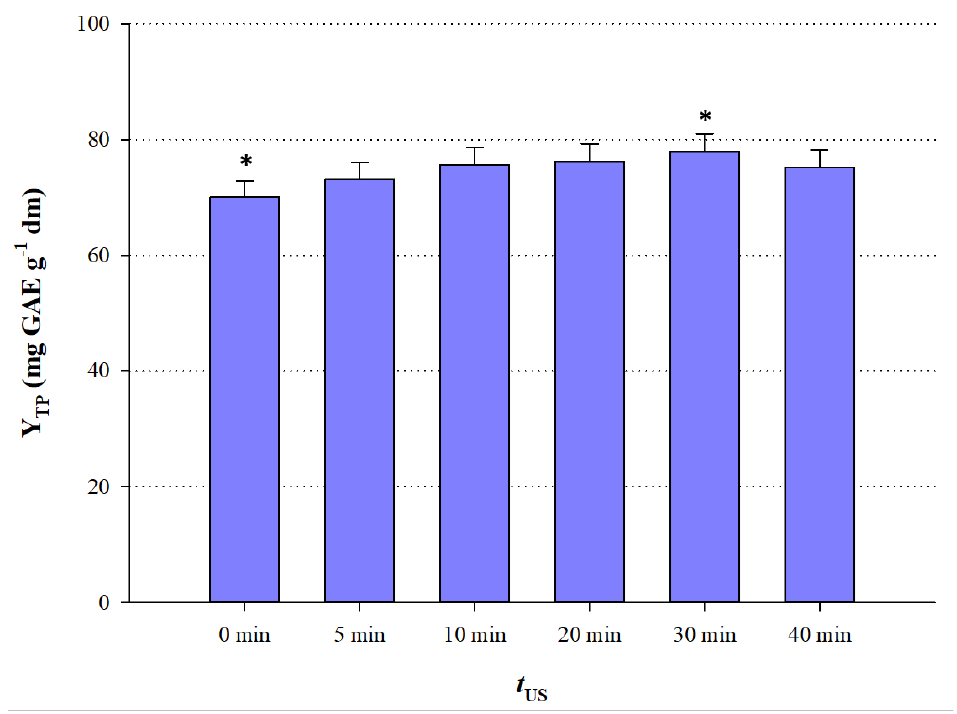
Figure 2. The effect of ultrasonication time ( t US ) on the extraction yield of total polyphenols. Extractions were performed with the 70% ( w/v ) aqueous GL-Nic (5:1), at 23 °C and R L/S = 35 mL g −1 dm. Assignment with “*” denotes statistically different value.